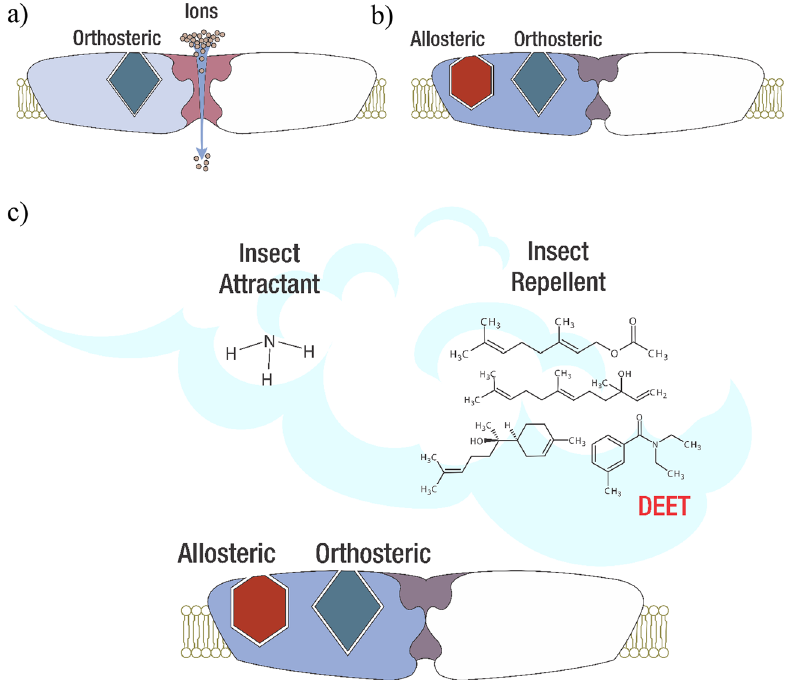
Figure 8. Possible repellent-ionic channel interaction. ( a ) The attractant molecule binds to an orthosteric site that allows ion flux through the cell membrane. ( b ) The same ionic channel possesses different binding sites called allosteric binding sites, in which other molecules bind. In the case of repellents, it is possible that the molecule binds to an allosteric site and inhibits the suitable ionic channel functioning in a small period. ( c ) The molecule effect in the ionic channel produces the mentioned inhibition. (Adapted by Vidal M. CINTROP from Dickens and Bohbot,